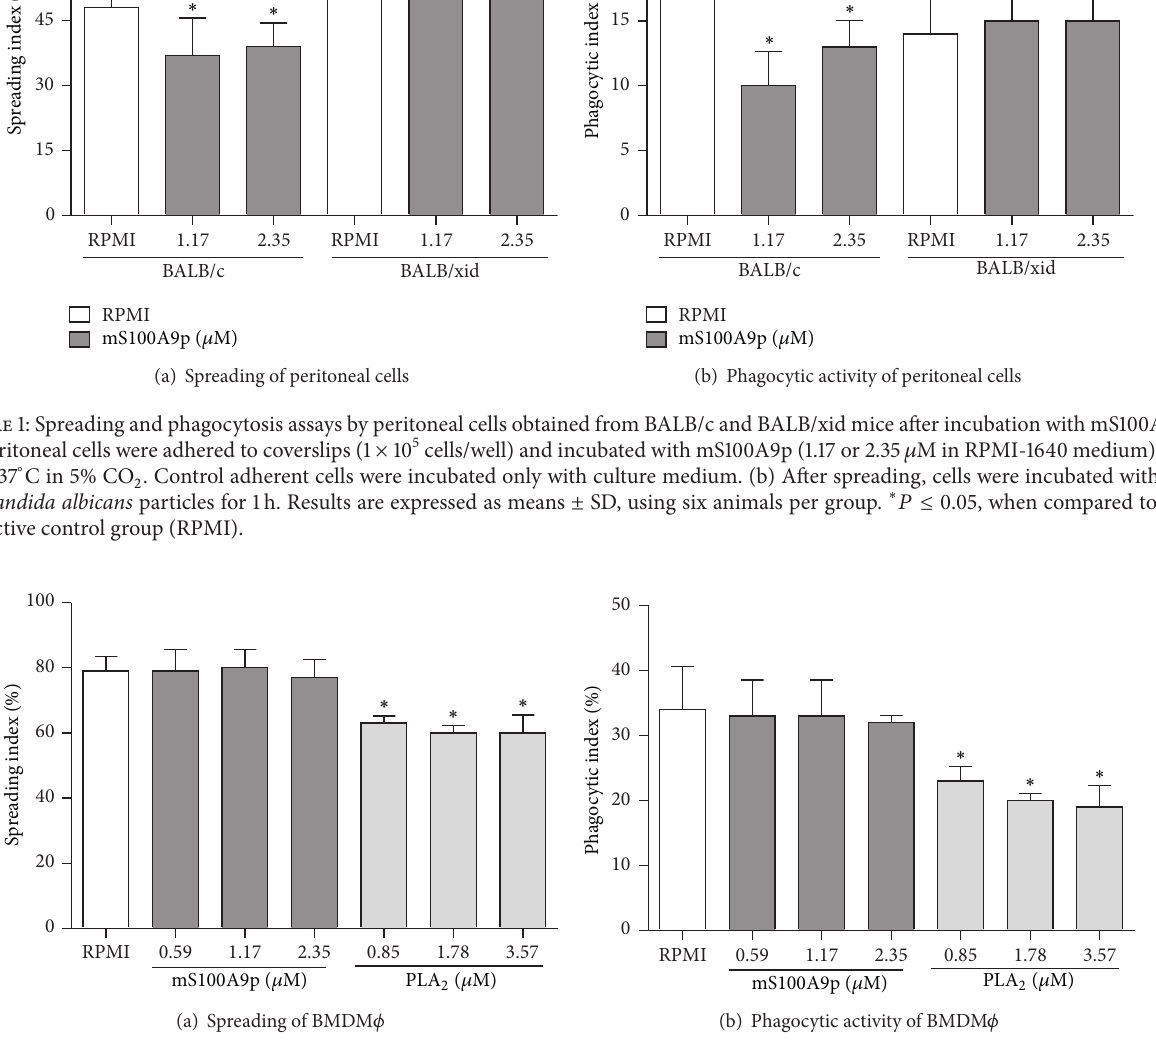
Figure2:Spreadingandphagocytosisassaysbybonemarrow-derivedmacrophages(BMDM 𝜙 )afterincubationwithmS100A9p.(a)BMDM 𝜙 adhered to coverslips (1 × 10 5 cells/well) were incubated with mS100A9p (0.59; 1.17; or 2.35 𝜇 M in RPMI-1640 medium), for 1h at 37 ∘ C in 5% CO 2 . Phospholipase A 2 (PLA 2 : 0.85; 1.78; 3.57 𝜇 M), in the same conditions of peptide, was used as positive control. BMDM 𝜙 controls were incubated only with culture medium. (b) After spreading, BMDM 𝜙 were incubated with 1 × 10 6 Candida albicans particles for 1h. Results are expressed as means ± SD, using five samples per group. ∗ 𝑃 ≤ 0.05, when compared to the control group